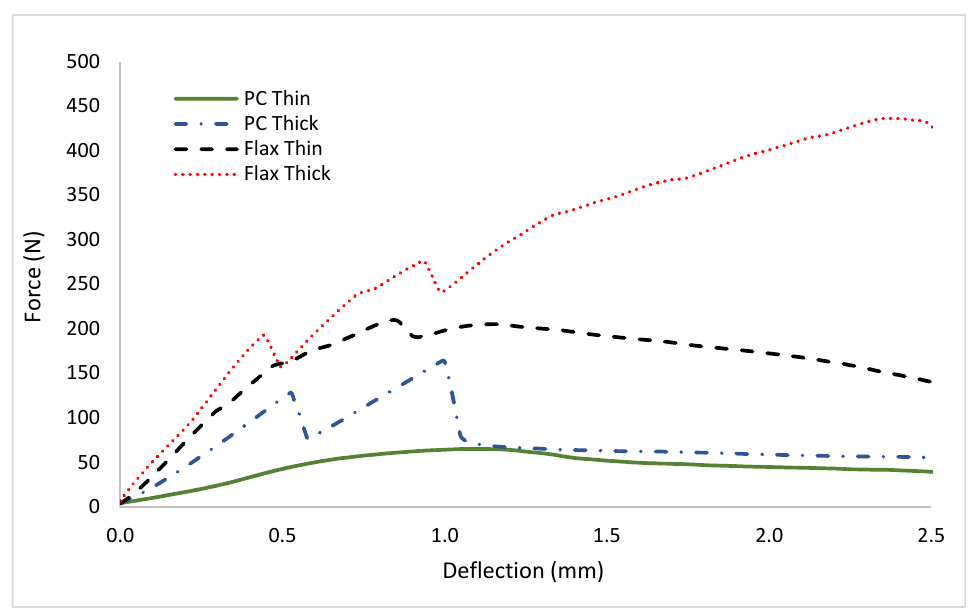
Figure 6. Force displacement graph of honeycomb sandwich panels under 3-point bending. (Note: Only 1 test for each sample is shown based on the avg. peak strength.)